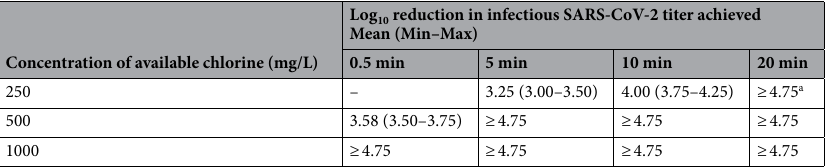
Concentration of available chlorine (mg/L)